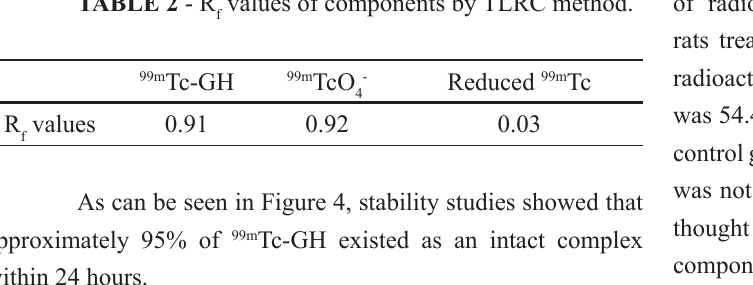
TABLE 2 - R values of components by TLRC method. f